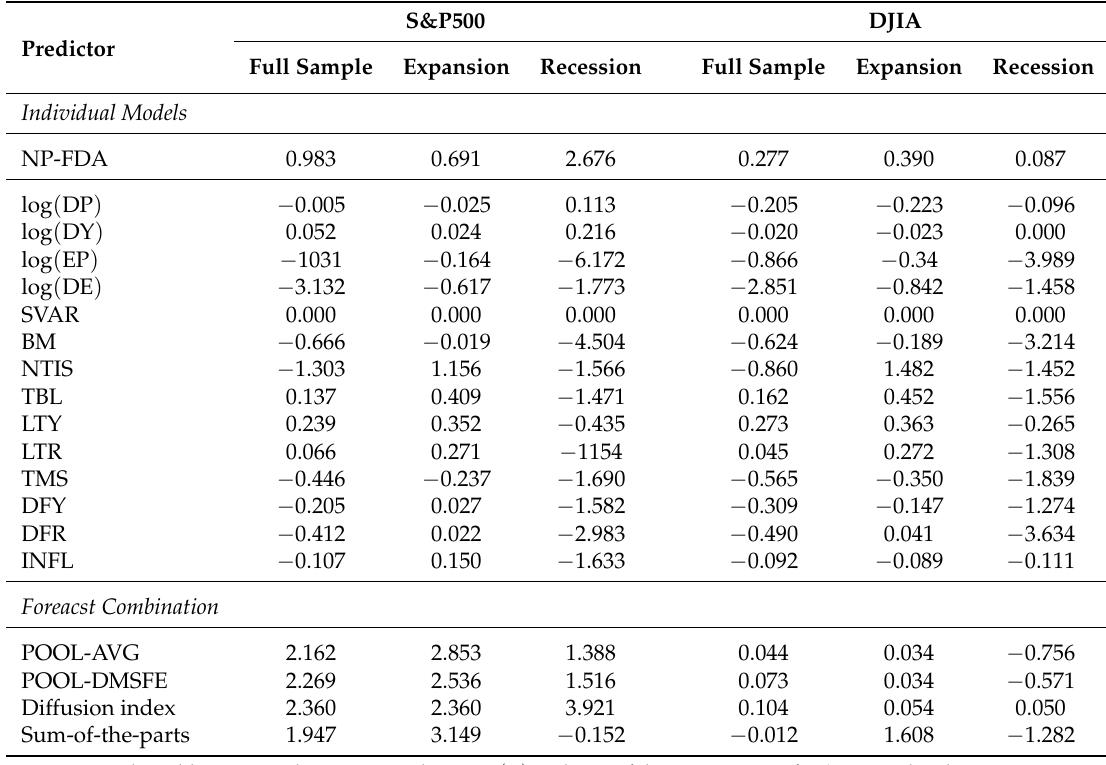
Table 3. Performance evaluation for an Investor with Mean Variance Utility with γ = 5, 1956:01-2019:12.